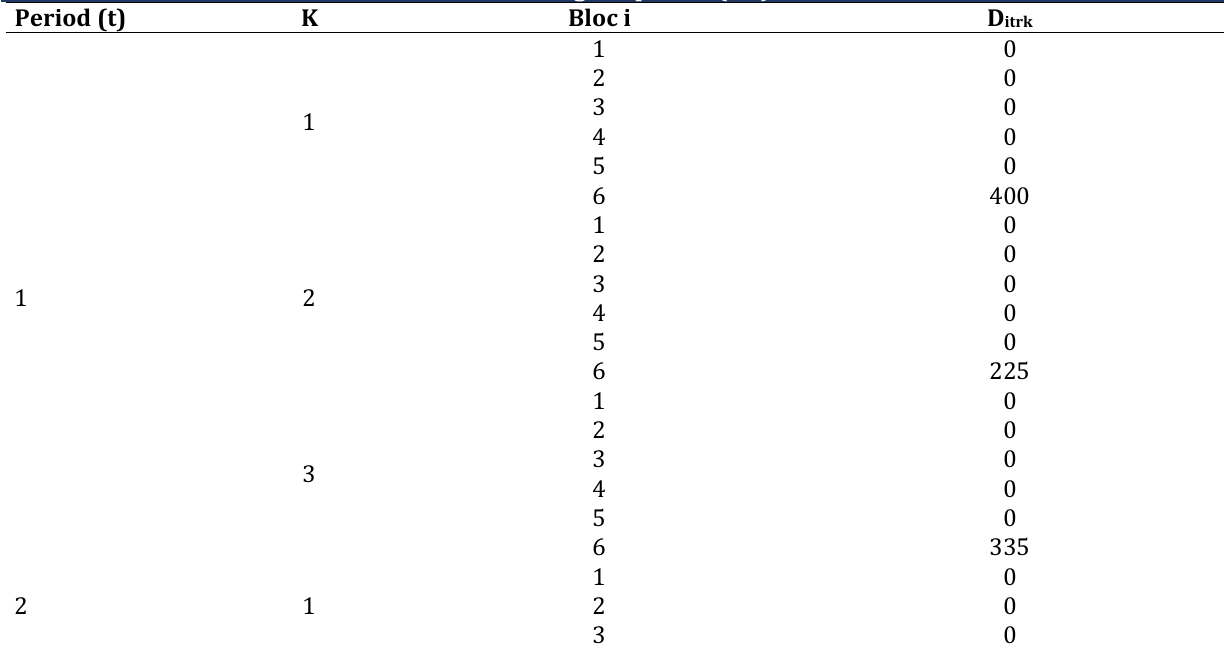
Table 8: Number of C1 container in 6 blocks during the period (T-t) Period (t) K Bloc